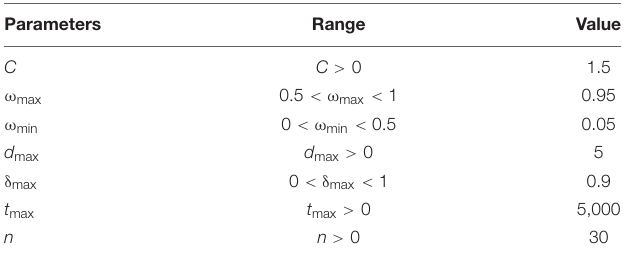
TABLE 3 | Parameters of grouped beetle antennae search (GBAS) for parameter identification of photovoltaic (PV) cell. Parameters Range